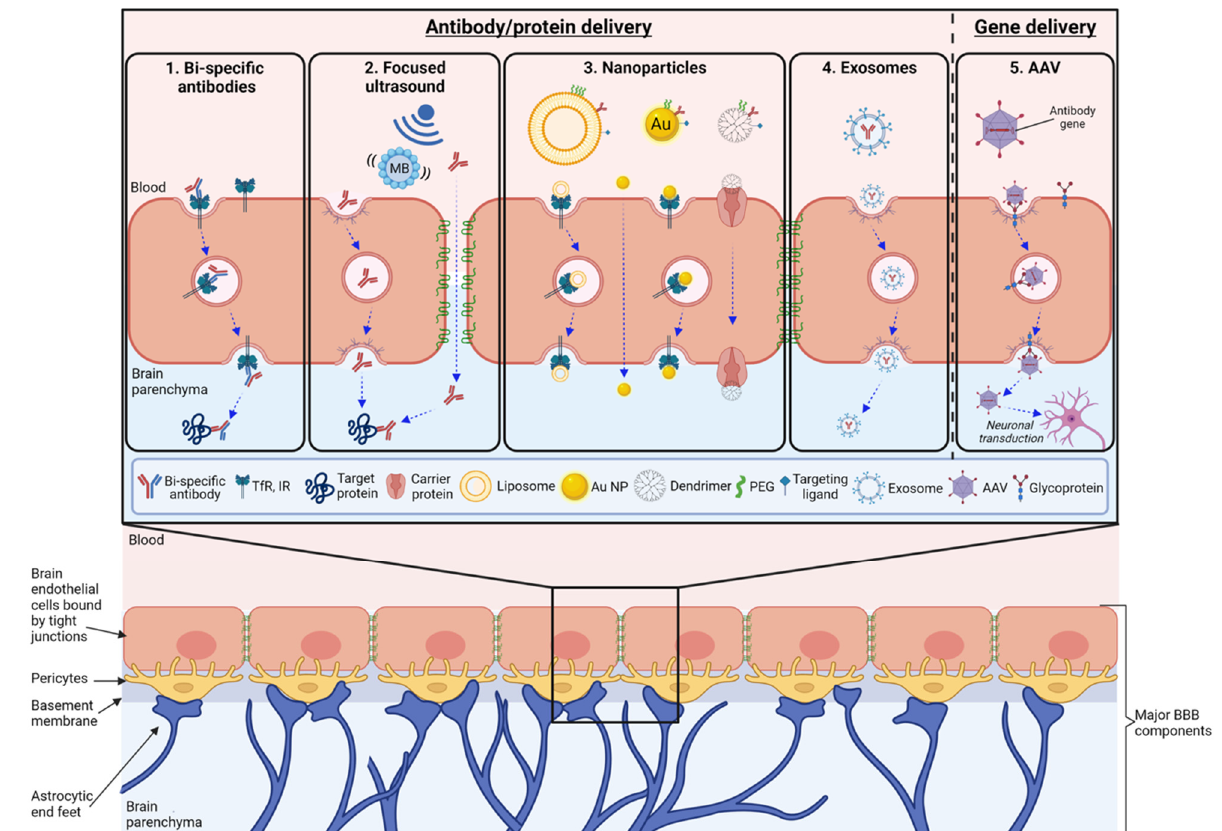
Figure 1. Current and emerging delivery strategies to enhance antibody penetration in the brain. The blood–brain barrier (BBB), composed of endothelial cells (BECs), the acellular basement membrane, pericytes and astrocytic end-feet, shields the brain microenvironment from foreign materials in the blood, including administered biotherapeutics. Strategies to